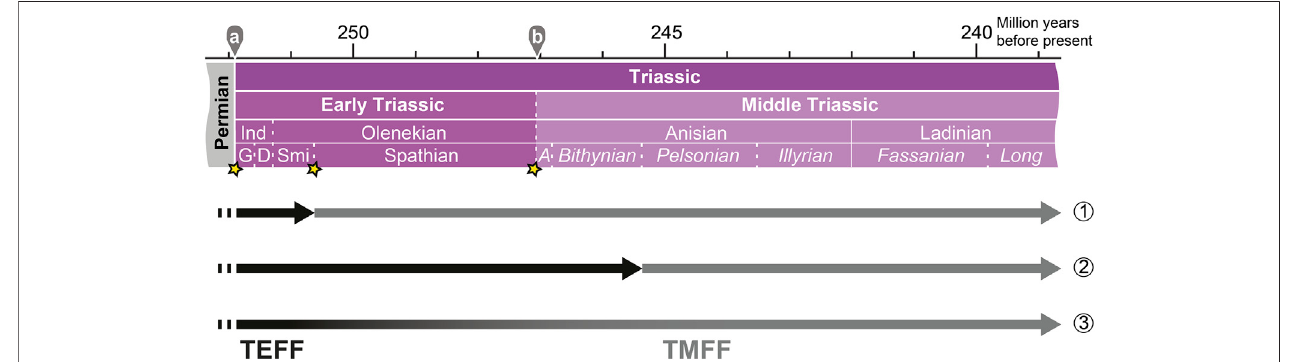
FIGURE 3 | Hypotheses for the replacement of the TEFF (Triassic Early Fish Fauna; Tintori et al., 2014a) by the TMFF (Triassic Middle Fish Fauna) during the diversi fi cation ofOsteichthyes intheEarly – Middle Triassic: (1)the SSBE hypothesis,(2)the Pelsonian explosion hypothesis,and (3)the gradual replacementhypothesis. For abbreviations for the absolute ages and stratigraphic ages: see caption of Figure 1 . See text for details.